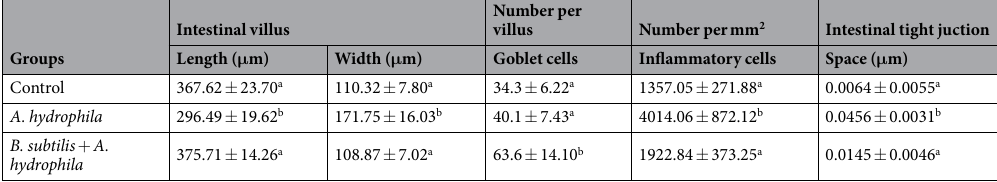
Table 1. Effect of A. hydrophila on the intestinal villi of length, width, number per villus of goblet, inflammatory cells and tight junction of space after orally intubation with B. subtilis 1 . 1 Values are means ± SD (n = 6), and different superscripts in the same column are significantly different ( P < 0.05), the below is the